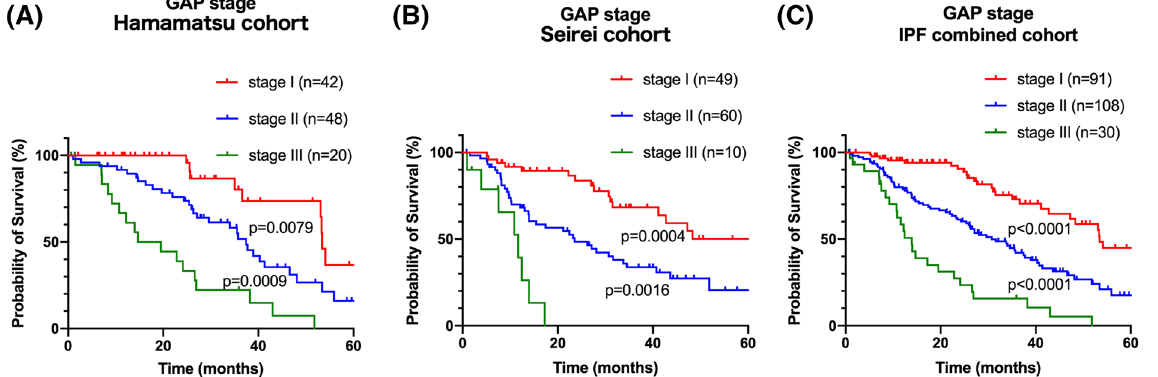
Figure 2. Prognostic classifications according to the GAP index at initiation of antifibrotic therapy in patients with IPF. Kaplan–Meier curves based on the data of the patients with IPF of the Hamamatsu cohort (A) , Seirei cohort (B) , and combined cohort (C) according to the GAP stage. P values were determined using the log-rank test. GAP Gender-Age-Physiology, IPF idiopathic pulmonary (Fig. 3), but not the ‘Age’ and ‘Gender’ factors (not shown). The C-index of the ‘GAP index: FVC (%)’ and ‘GAP index: DLCO (%)’ were 0.668 and 0.655, respectively. Prognostic factors in patients with IPF treated with AFT.